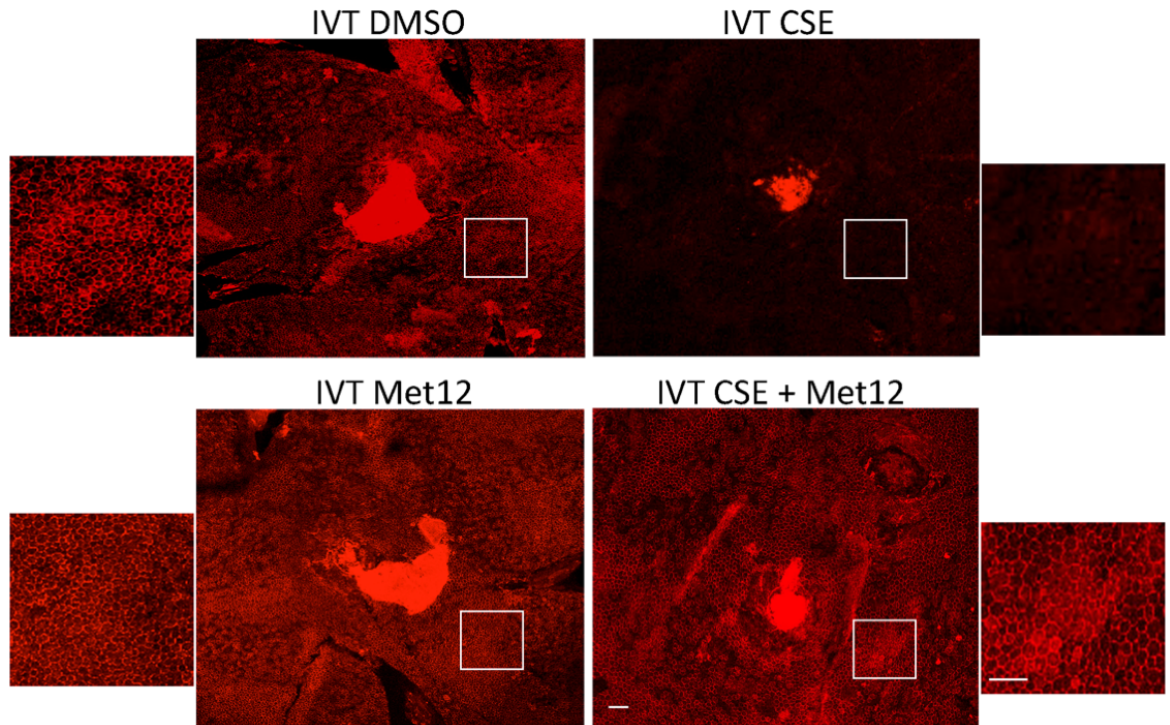
Figure 3. Peptide Fas inhibitor protects RPE from cigarette smoke extract-induced damage. Wild-type mice ( n = 5 per group) were treated with the either DMSO (vehicle control) or the Fas inhibitor Met12 by intravitreal (IVT) injection and then IVT CSE 3 days later. After 10 days, RPE flatmounts were immunolabeled with anti-ZO-1. The RPE had a dramatic loss of hexagonal cell shape following IVT CSE ( upper right ). This was prevented with Met12 treatment ( bottom right ). White boxes highlight the location of the magnified images of the RPE. Bar = 50 µm.